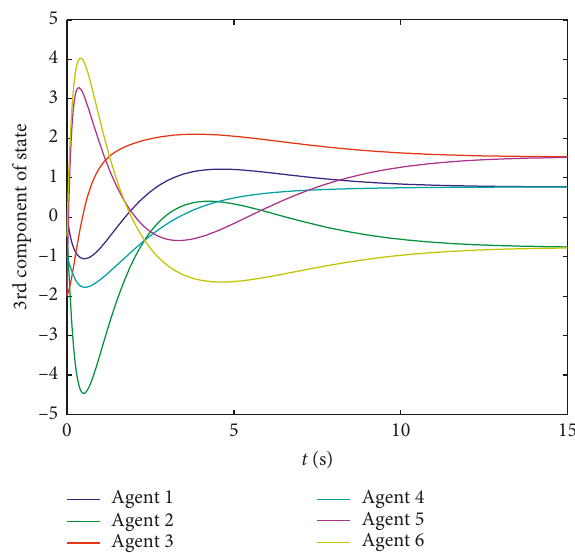
Figure 9: Trajectories of x